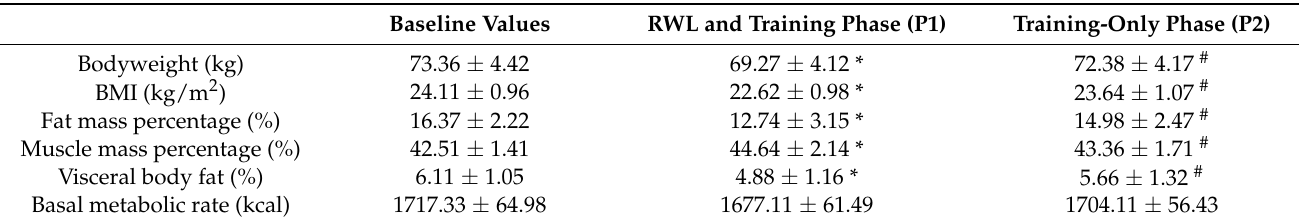
Table 1. Descriptive characteristics of wrestlers’ body composition (n =